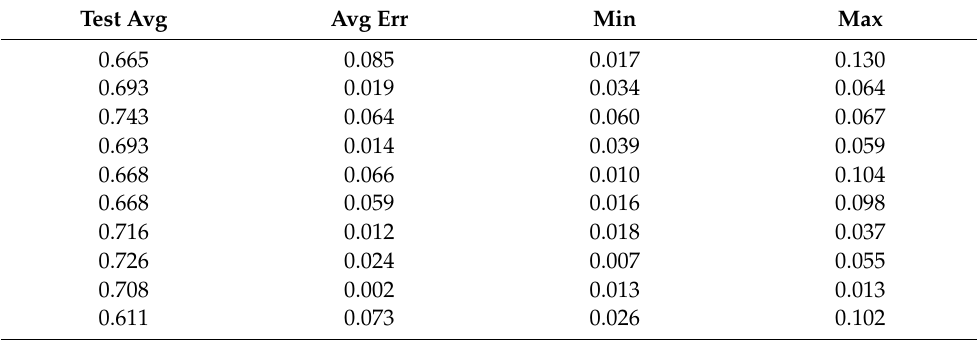
Table A21. Set 1, trials 11–20 data (single 0.5 PR value).